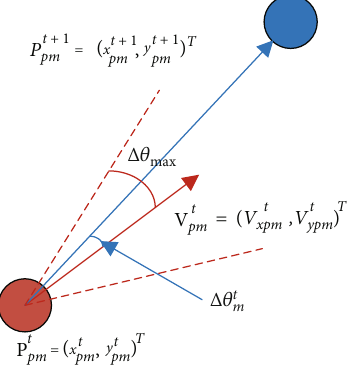
Figure 3: Schematic diagram of motion